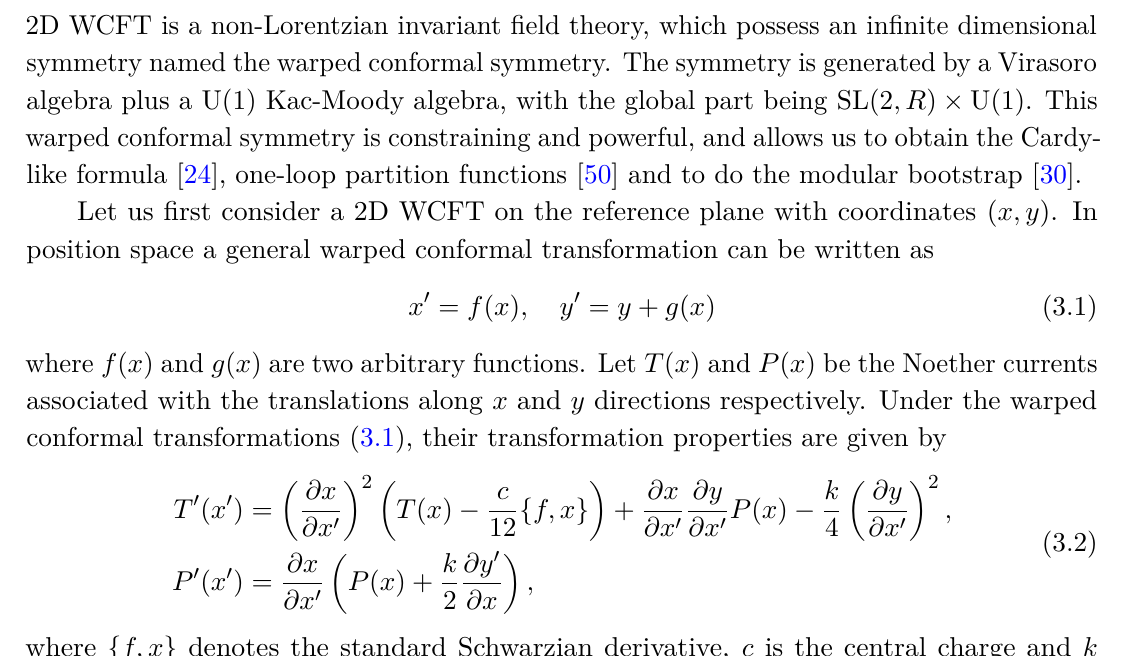
and B is its AB